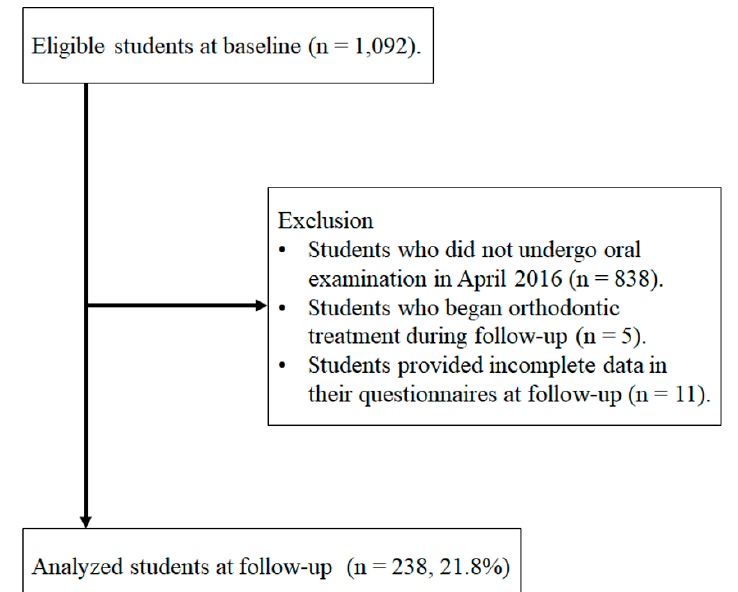
Figure 1. Flow chart showing protocols for selecting analysed students from among first-year students who did not meet the exclusion criteria (malocclusion conditions, age and orthodontic treatment).